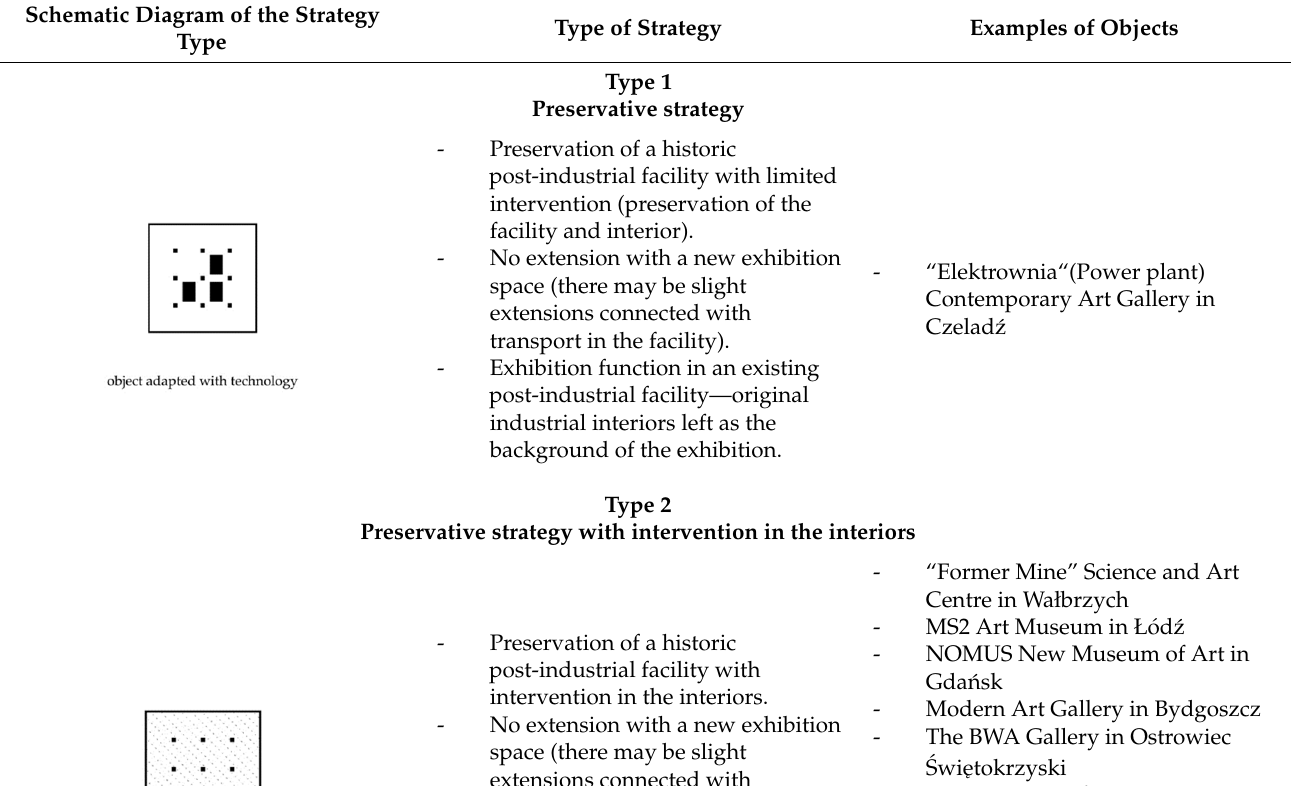
Table 2. Adaptive reuse strategies of post-industrial objects for art exhibition function in Poland. Adaptive Reuse Strategies of Post-Industrial Objects for the Functions of Art Exhibition in Poland Schematic Diagram of the Strategy Type